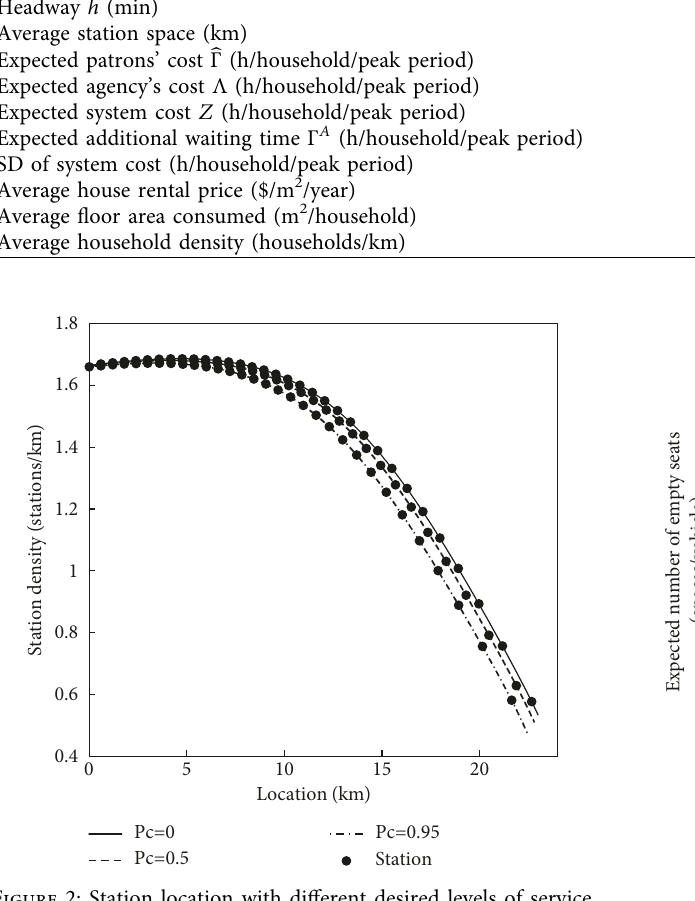
Figure 2: Station location with different desired levels of service reliability.